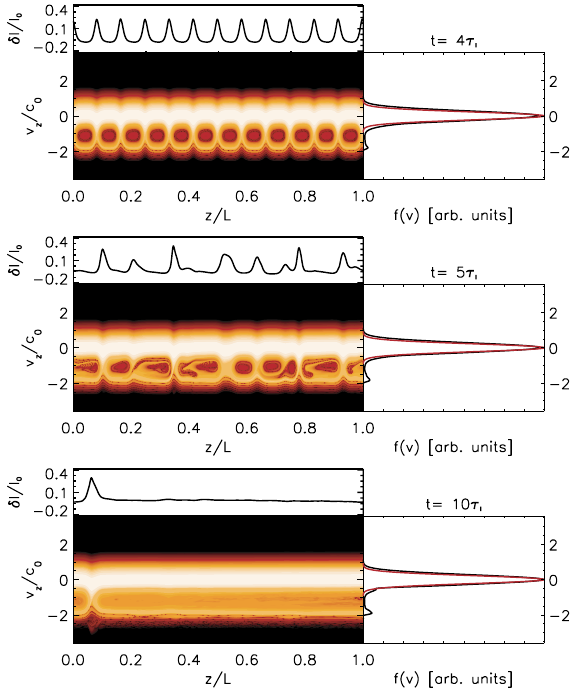
FIG. 9. (Color) Contour plots of the distribution function ln f (cid:2) z , y z (cid:3) together with the line density r L (cid:2) z (cid:3) and the velocity distribution f (cid:2) y z (cid:3) obtained from the Vlasov simulation for U sc (cid:2) 10 , V bb (cid:2) 0.1 , and n r (cid:2) 12 .